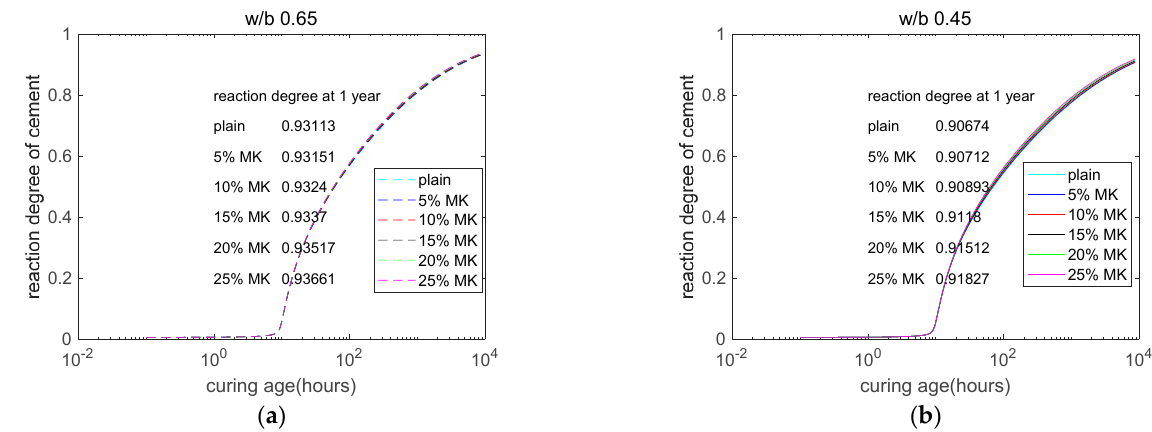
Figure 2. Hydration levels of Portland cement in cement–metakaolin blends. ( a ) hydration extent of Portland cement: water/binder ratio 0.65. ( b ) hydration extent of Portland cement: water/binder ratio 0.45.